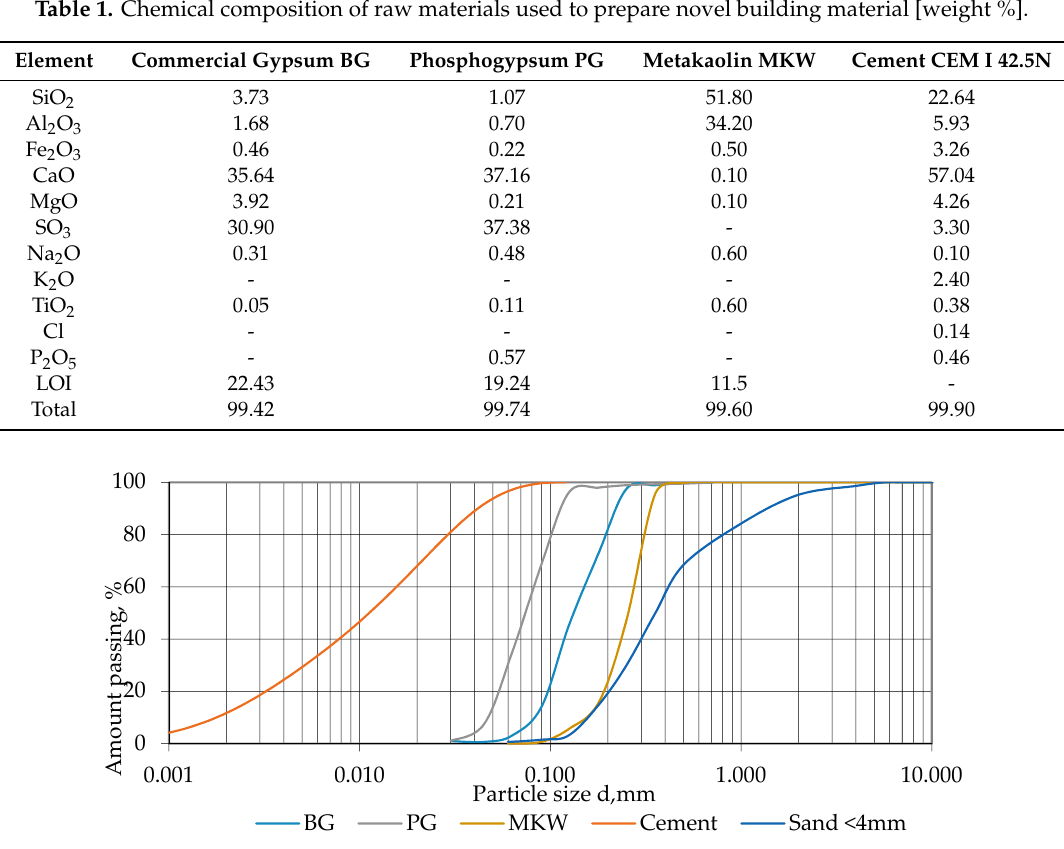
Figure 1. The particle size distribution of the raw materials used to prepare novel building material.